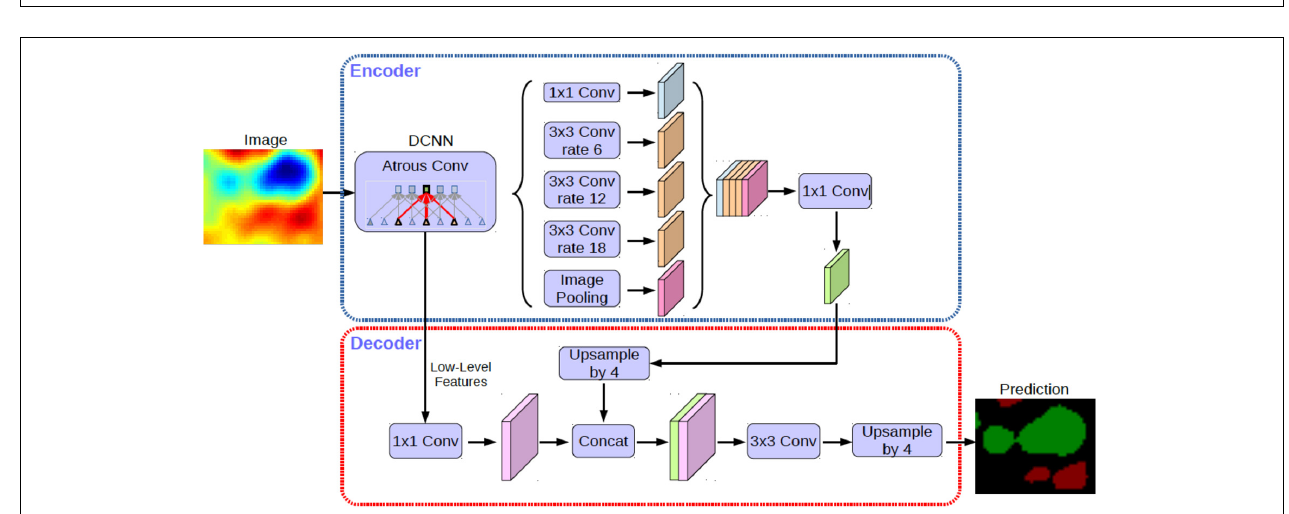
FIGURE 2 | Schematic diagram of DeepLab